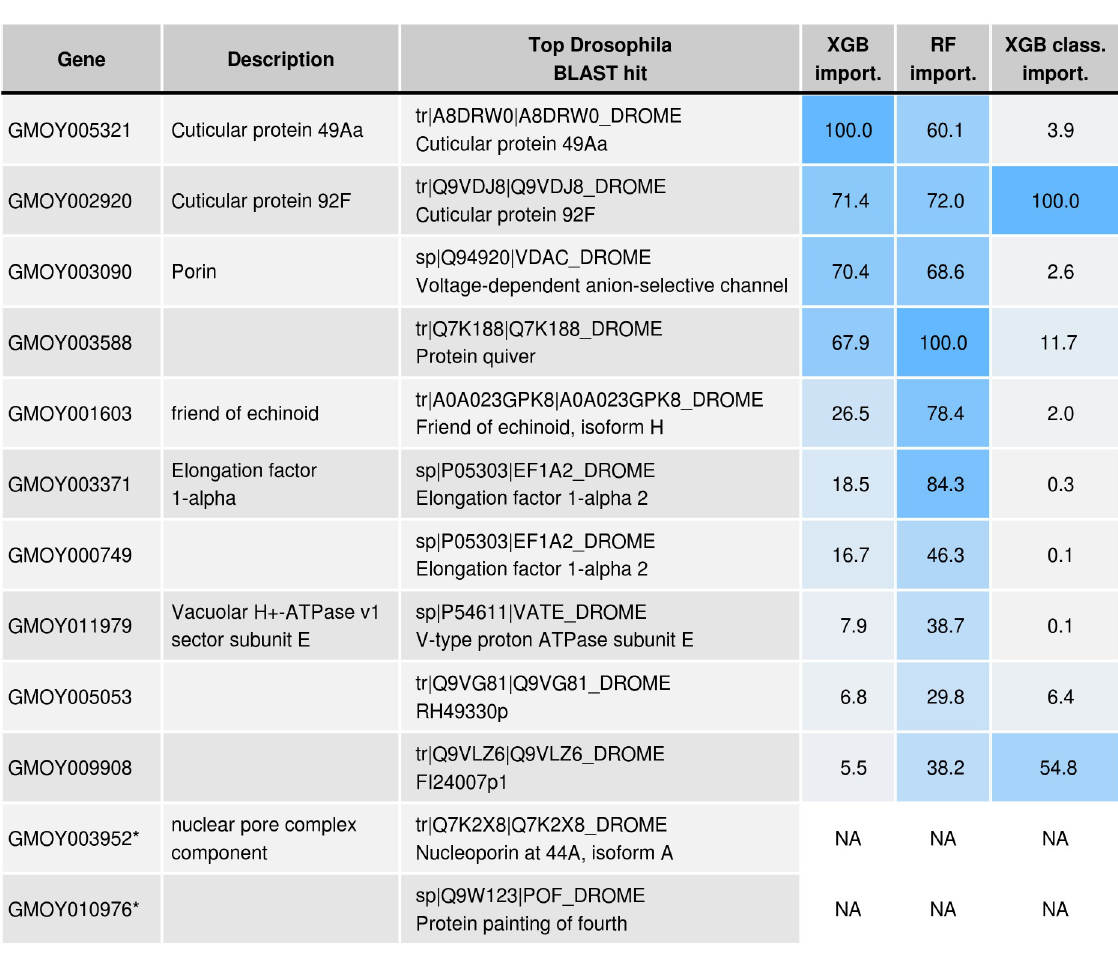
Fig 4. Ten age-related genes and two housekeeping genes (denoted with � ) were used for qPCR analysis. Gene descriptions are taken from the Contig names in the GmorY1.9 proteome, downloaded from www.vectorbase.org/downloads on 2 nd of March 2019. Top Drosophila BLAST hits obtained by blasting the GmorY1.9 proteome against the D. melanogaster swissprot proteome. Variable importance of each gene shown for XGB, random forest (RF) and XGB classifier models trained with all predictor